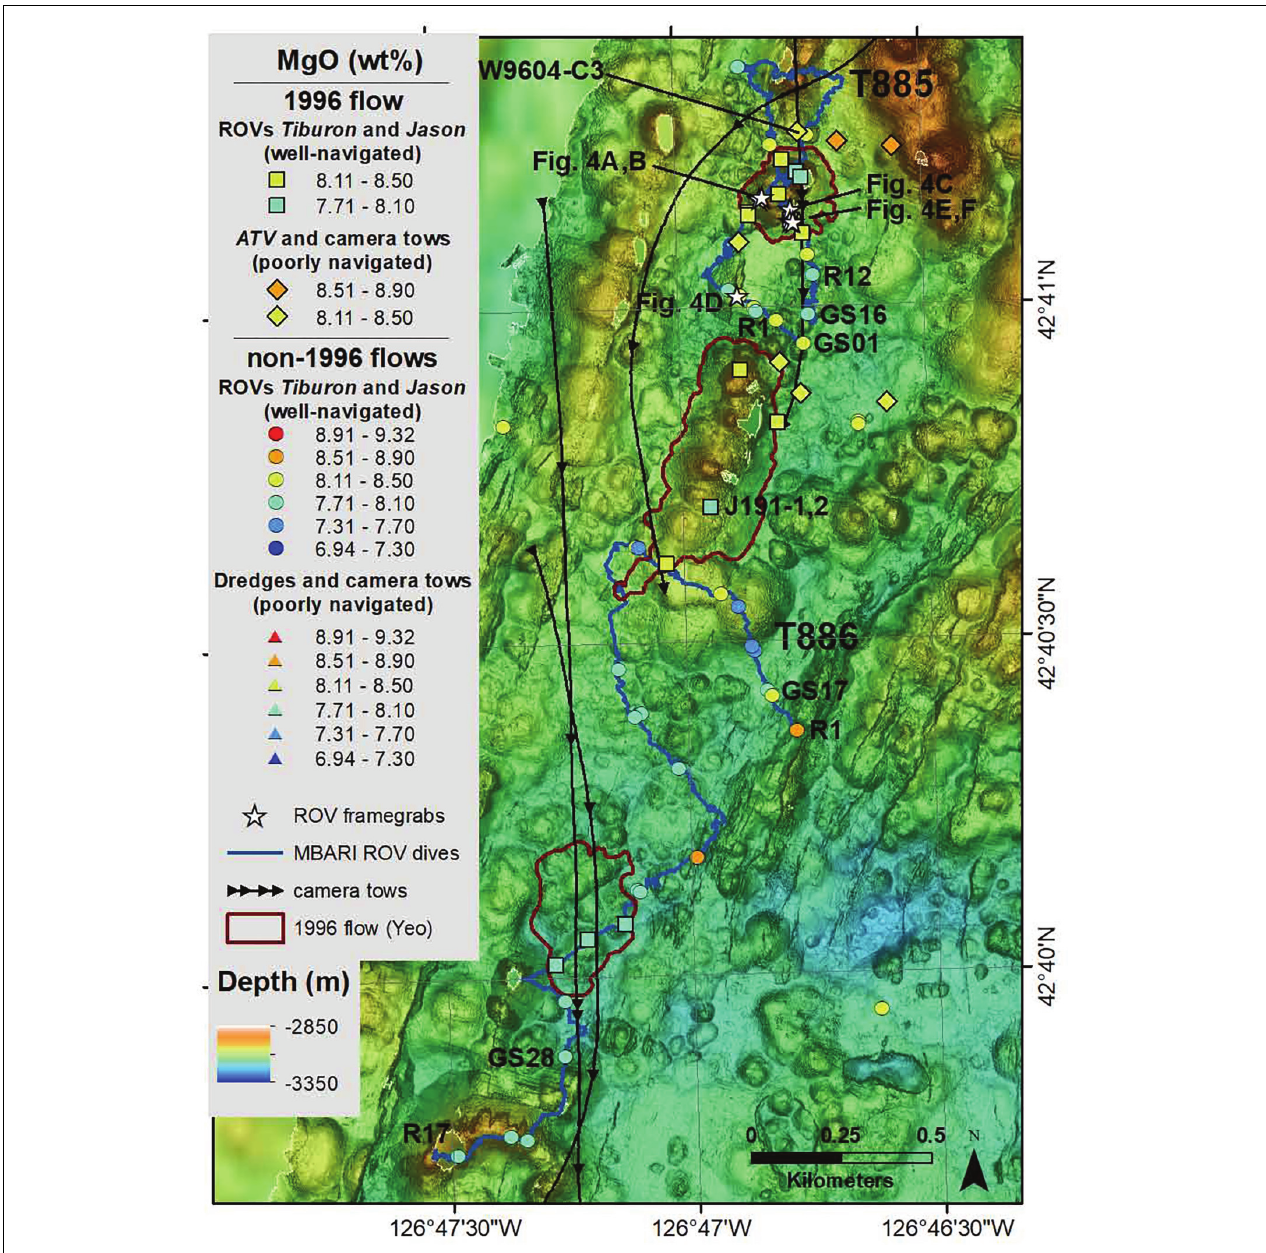
FIGURE 3 | Map of 1996 lava flows with flow extent from Yeo et al. (2013) as red outline. Blue lines are tracks of ROV Tiburon dives T885 and T886 (Davis et al., 2008; Supplementary Table S1 ) with some rock (R) and glass suction (GS) samples labeled. Fifteen 1996 flow samples from Rubin et al. (1998) include seven well-located ROV Jason samples, seven poorly located ROV ATV samples, and one sample recovered on a camera sled (black curved lines show camera tow tracks from Chadwick et al., 1998, note that the camera tow sample – yellow diamond near N end of map – does not plot within the AUV mapped 1996 flow). Locations of video framegrabs from dive T885 in Figure 4 are